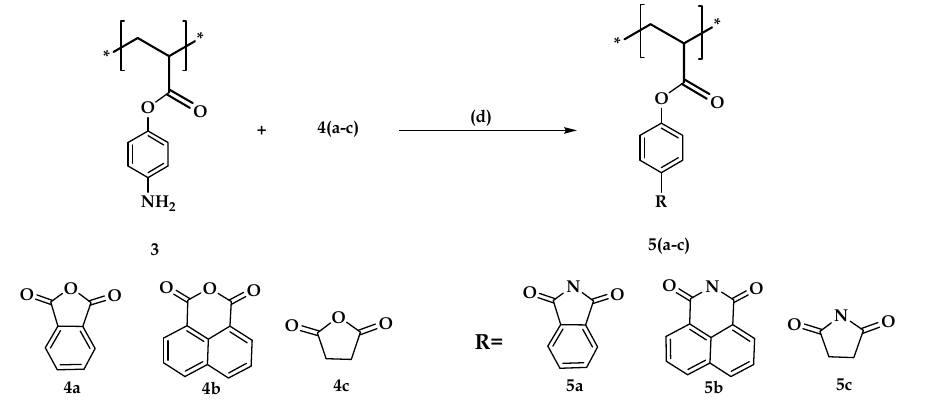
Figure 7. Reagents and conditions: (d) acetic acid, 130 °C, reflux, 5 h. Figure 7. Synthesis of imide derivative of polyacrylic acids 5a to 5c . Reagents and conditions: (d) acetic acid, 130 ˝ C, reflux, 5